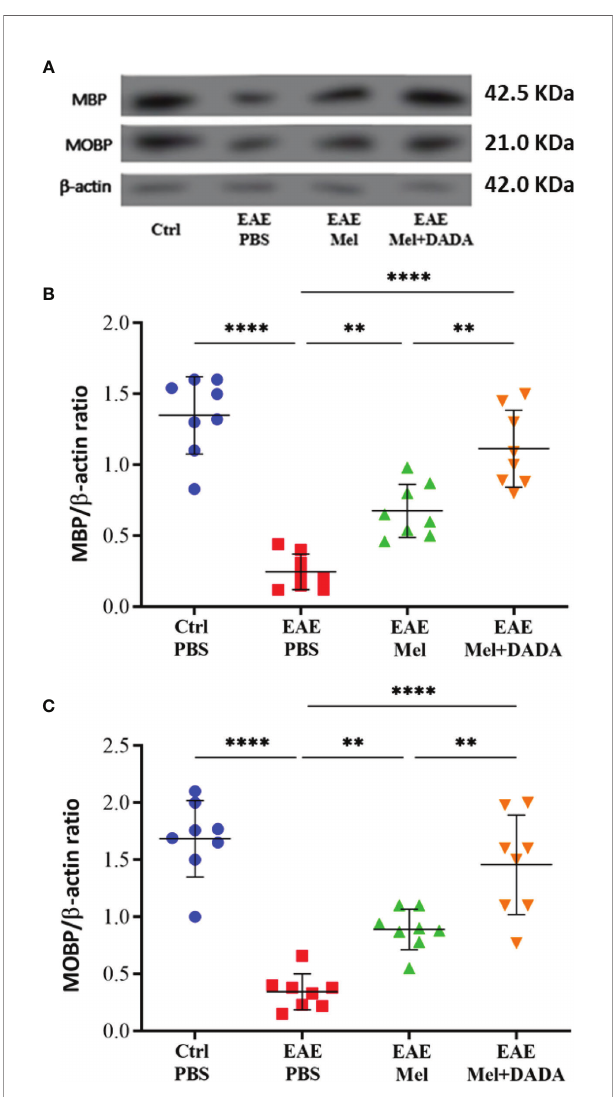
FIGURE 3 | Oligodendrocyte ’ s expression levels. (A) Western blot analysis of myelin basic protein (MBP) and myelin-associated oligodendrocytic basic protein (MOBP) in the brain. The two markers (MBP and MOBP) were run alongside the same b -actin as housekeeping control. (B, C) Quantitative analysis for MBP and MOBP proteins, respectively. Values are expressed as the Mean ± SEM. Each group included 8 mice (n = 8). Statistical analysis was performed by one-way analysis of variance (ANOVA) followed by Tukey ’ s test. Signi fi cance is indicated by **p < 0.01; and ****p <